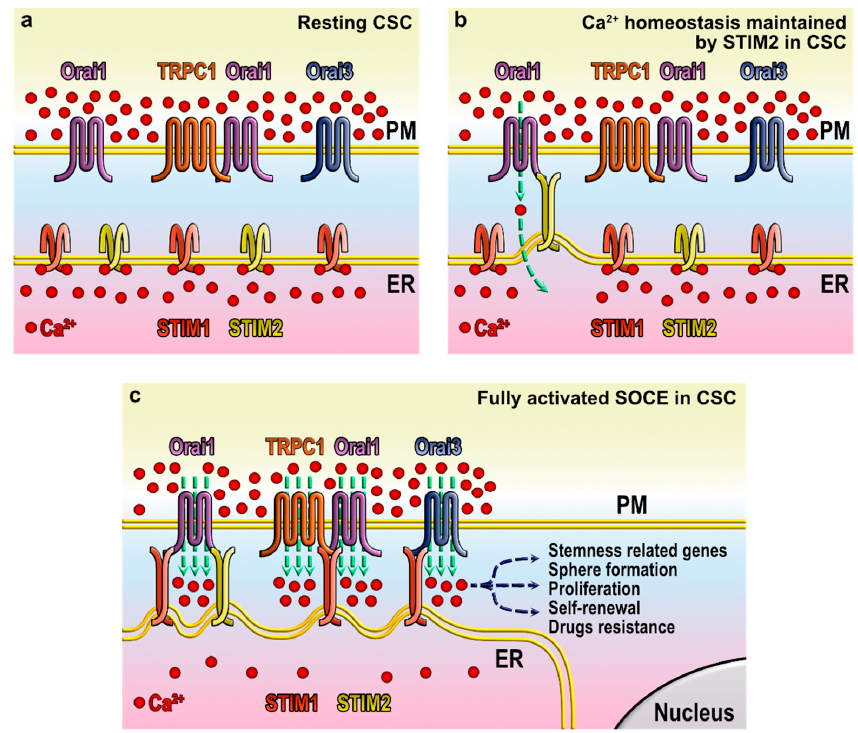
Figure 2. Store-operated Ca 2+ in cancer stem cells. Cartoon depicting a hypothetical mechanism of SOCE in CSC, based on our current knowledge in non-tumoral cells: ( a ) when intracellular Ca 2+ stores are filled, STIM proteins remain in their quiescent conformation; ( b ) small changes in luminal Ca 2+ concentration are controlled by STIM2, briefly activating CRAC channels to replenish the res- ervoirs; ( c ) massive Ca 2+ store depletion triggers the activation of STIM proteins and the channels in plasma membrane, resulting in the critical increase in cytosolic Ca 2+ required for tumorigenic re- sponses.